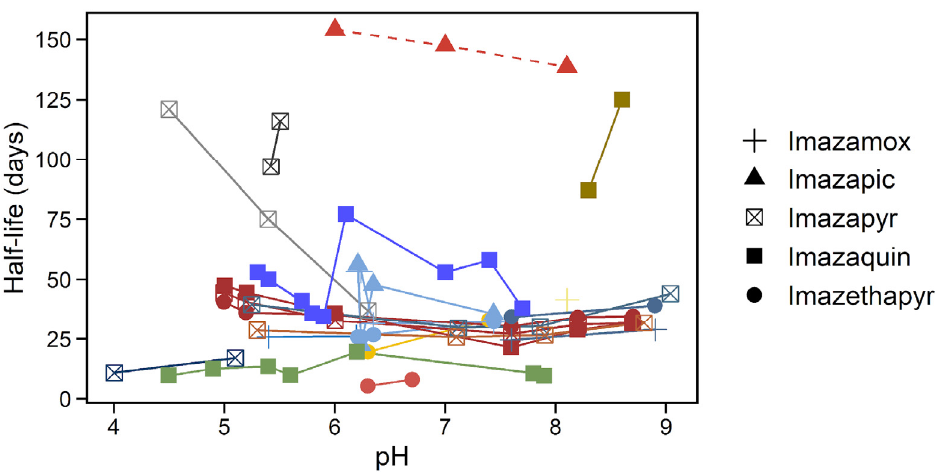
Figure 7. Relationship between soil pH and imidazolinone half-life (days). The dashed line corre- sponds to the work of Su et al. [25].